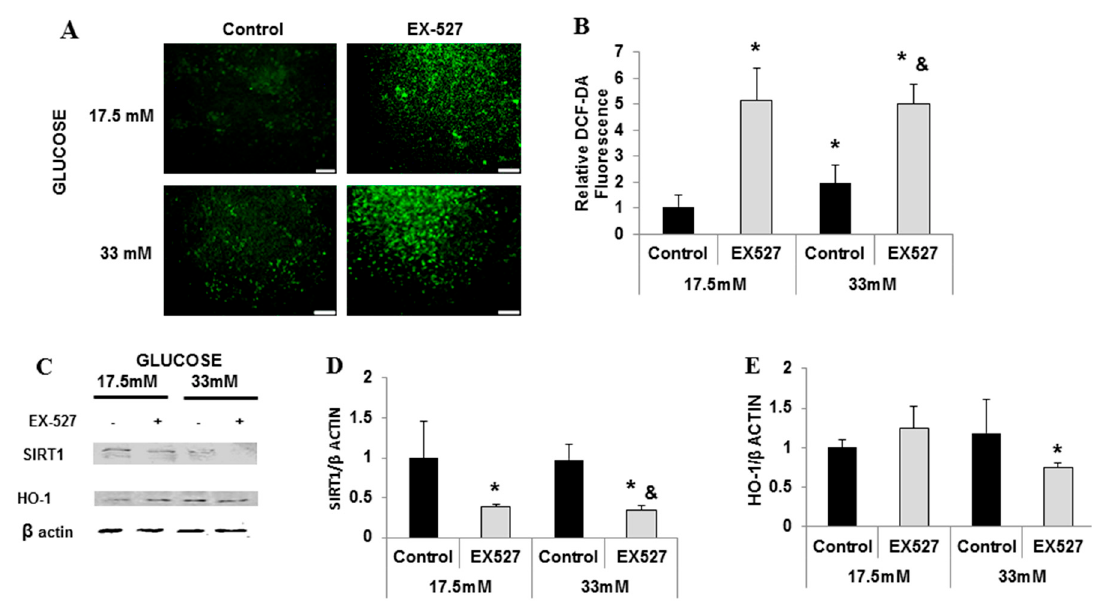
Figure 4. SIRT1 is required for the expression of PGC ‐ 1 α and HO ‐ 1. Neonatal rat cardiomyocytes were exposed to 17.5 mM and 33 mM of glucose and treated with the SIRT1 inhibitor EX ‐ 527. Cells were stained with DCF ‐ DA, Scale bar: 100 μ m. ( A a–d), and fluorescence was measured using fluorimeter ( B ). Representative Western blots for SIRT1, PGC ‐ 1 α , and HO ‐ 1 for cells treated with EX ‐ 527 ( C ), densitometry analysis for SIRT1 ( D ), and HO ‐ 1 ( E ). Results were normalized to the group exposed to 17.5 mM of glucose. * p < 0.05 vs. control, & p < 0.05 vs. 33 mM of control, n = 4 in each group. Values represent mean ± SD.